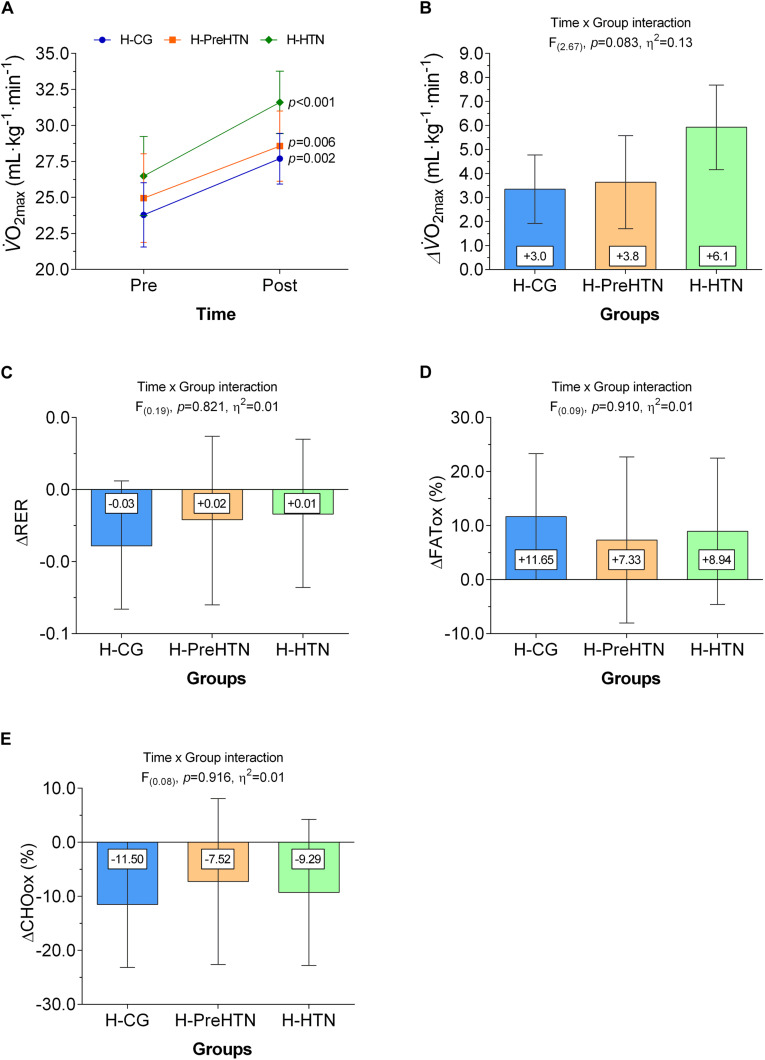
Maximum oxygen consumption (V.O2max), respiratory exchange ratio (RER), FATox and CHOox utilization during exercise measured by indirect calorimetry measured in healthy normotensive, prehypertensive, and hypertensive subjects. Panel (A) show absolute values of V.O2max, and Panel (B) show V.O2max in delta values pre-post 16-weeks HIIT intervention. Panel (C) show RER peak during exercise in delta values pre-post 16-weeks HIIT intervention. Panel (D) shows fat utilization during exercise in delta values pre-post 16-week high-intensity interval training (HIIT) intervention. Panel (E) shows CHO utilization during exercise in delta values pre-post 16-week HIIT intervention Groups are described as (H-CG) HIIT-normotensive control group, (H-PreHTN) HIIT-prehypertensive group, and (H-HTN) HIIT-hypertensive group. Within the mixed model, we calculated 95% Cis and P values for 3 prespecified intergroup contrasts and for change for all continuous variables within each group over time with adjustment for the baseline values, age, gender and BMI as covariates. A Sidack’s post hoc test was used for multiple comparisons. All results are presented as least-squares means with 95% confidence intervals (CIs).